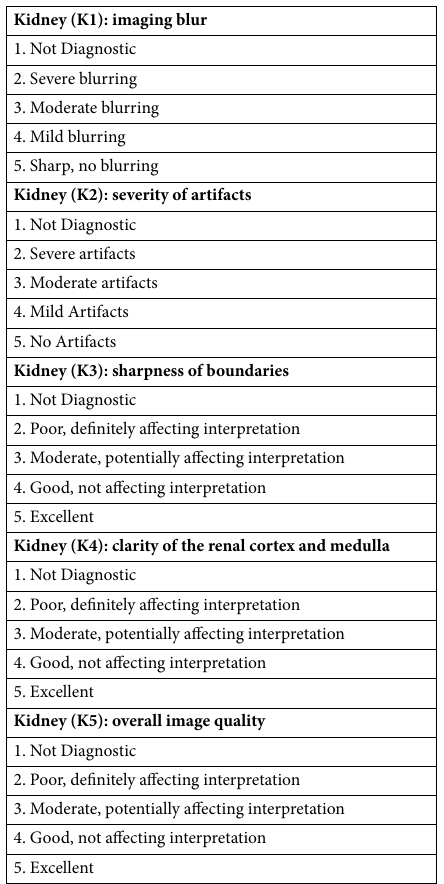
Table 7. The criterion of the image quality scores for coronal kidney DWI in our